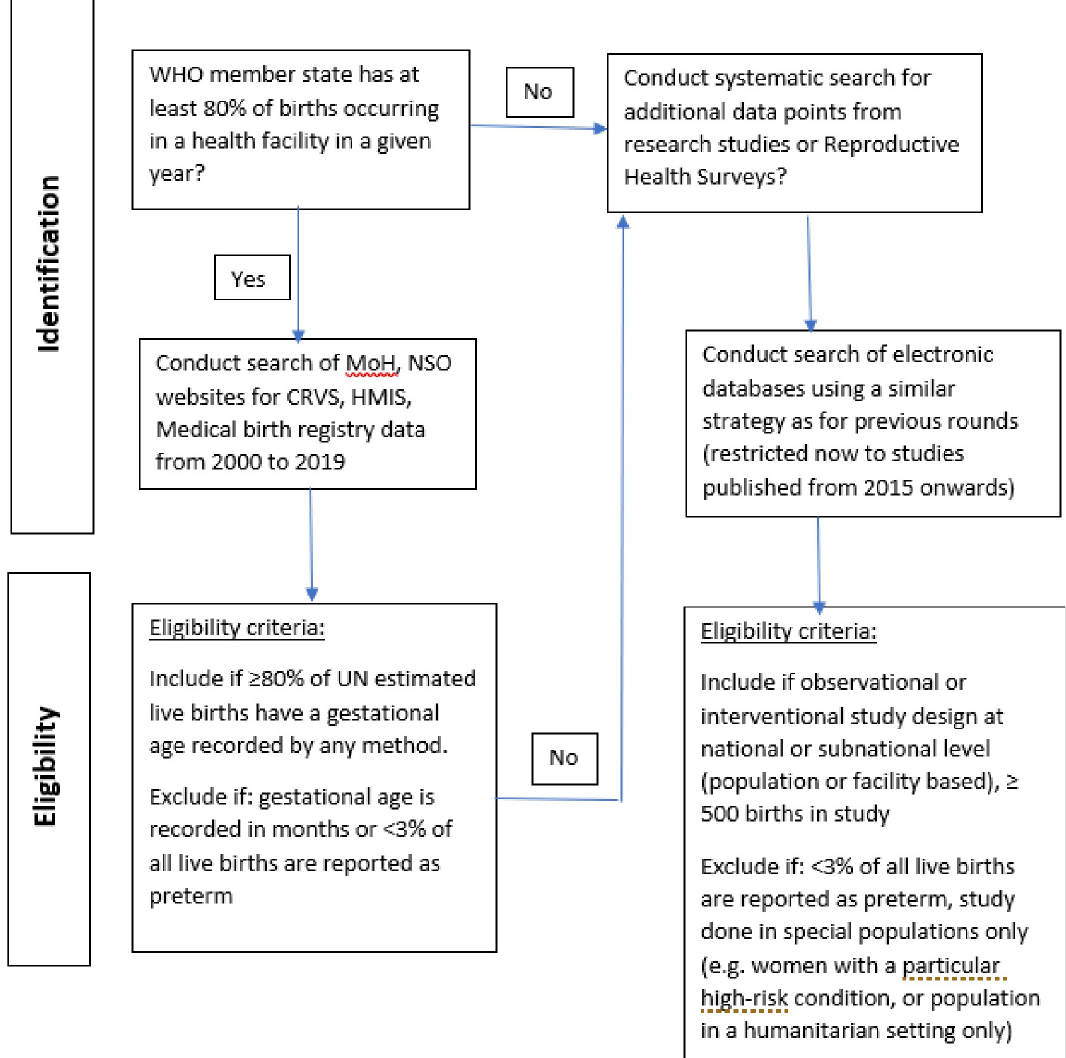
Fig 1. Flow diagram of the data search and review